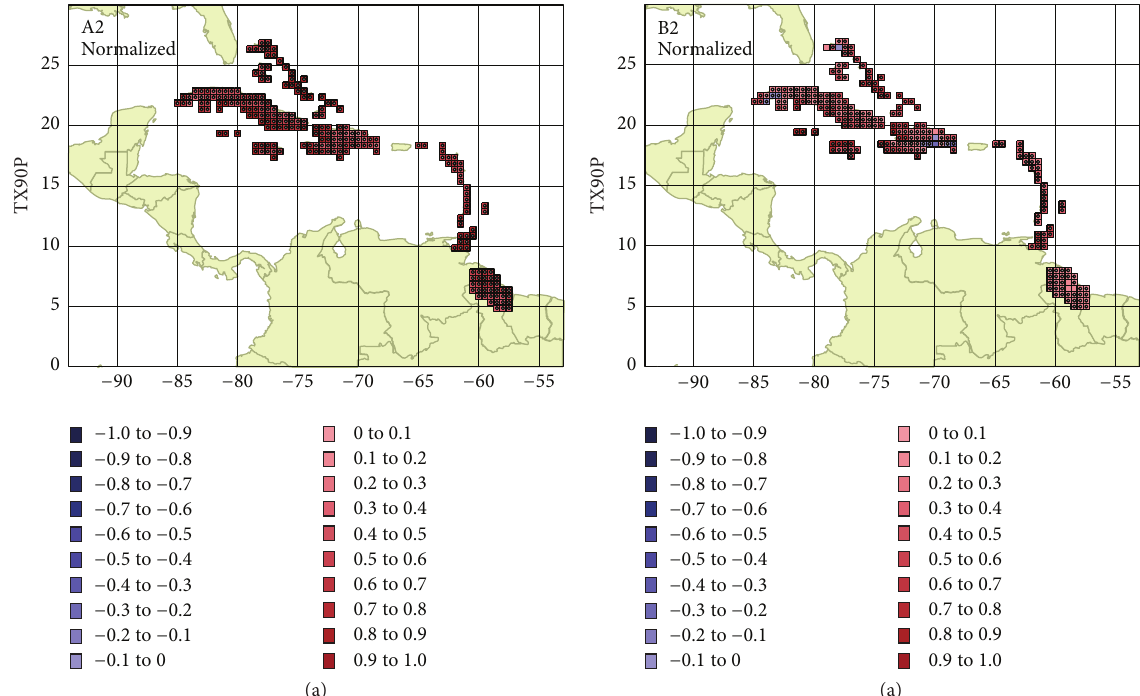
Figure 7: Projected normalized change in trends for TN10P, TX10P, TN90P and TX90P for 2071–2099 relative to 1961–1989 for the A2 (left panels) and B2 (right panels) IPCC SRES scenarios of each variable. Blue colour indicates negative and red colour indicates positive trends. Statistically significant trends are indicated with white stippling.